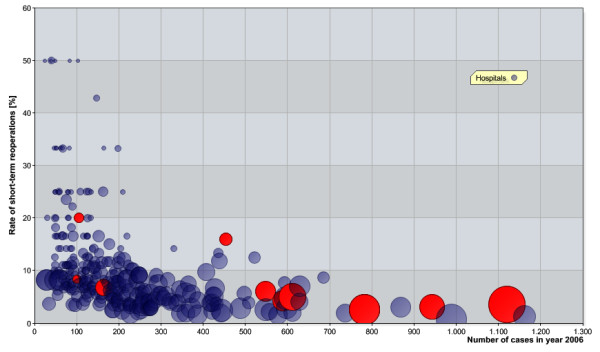
Scatter plot as in Figure1but for knee endoprosthetic joint implantations.